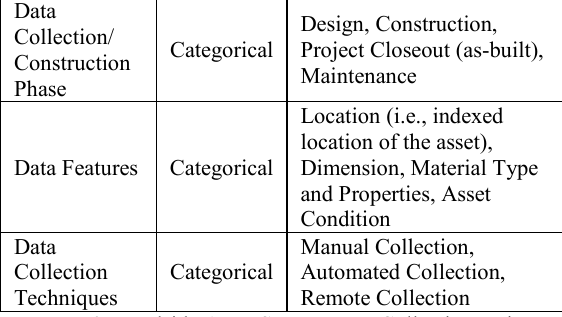
Table 2 . Roadside Asset System Data Collection major variables and variable levels.